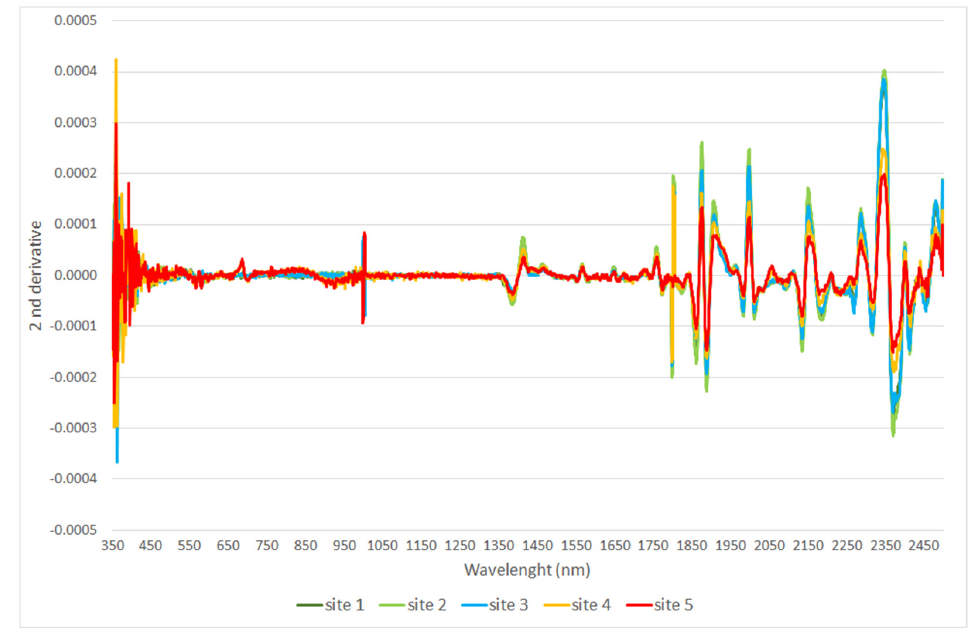
Figure 7. Second derivative of spectral characteristics for the Hallstätter Glacier foreland test sites.